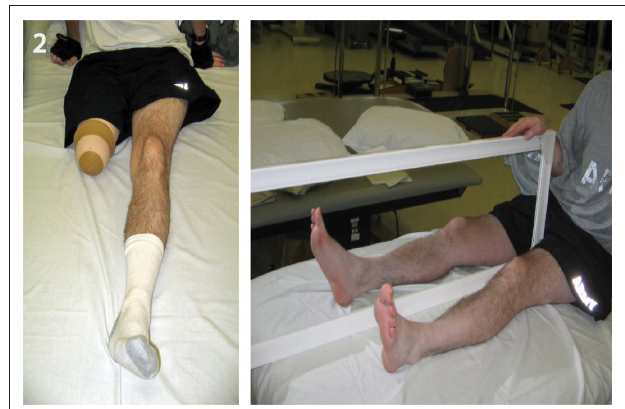
FiguRE 3 | Change in pain in subjects measured using the VAS. Group medians are depicted for each time point. After the first month (week 4), subjects in the covered mirror and mental visualization groups were switched to using the uncovered mirror. N = 6 per group after accounting for dropouts. Reprinted with permission from the New England Journal of Medicine (Chan et al., 2007).